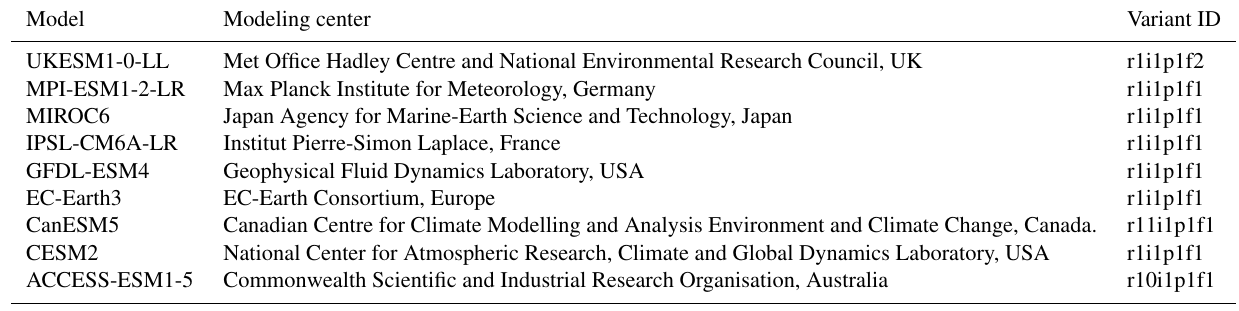
Table 1. List of the nine employed CMIP6 models and the modeling groups that provided them. Model